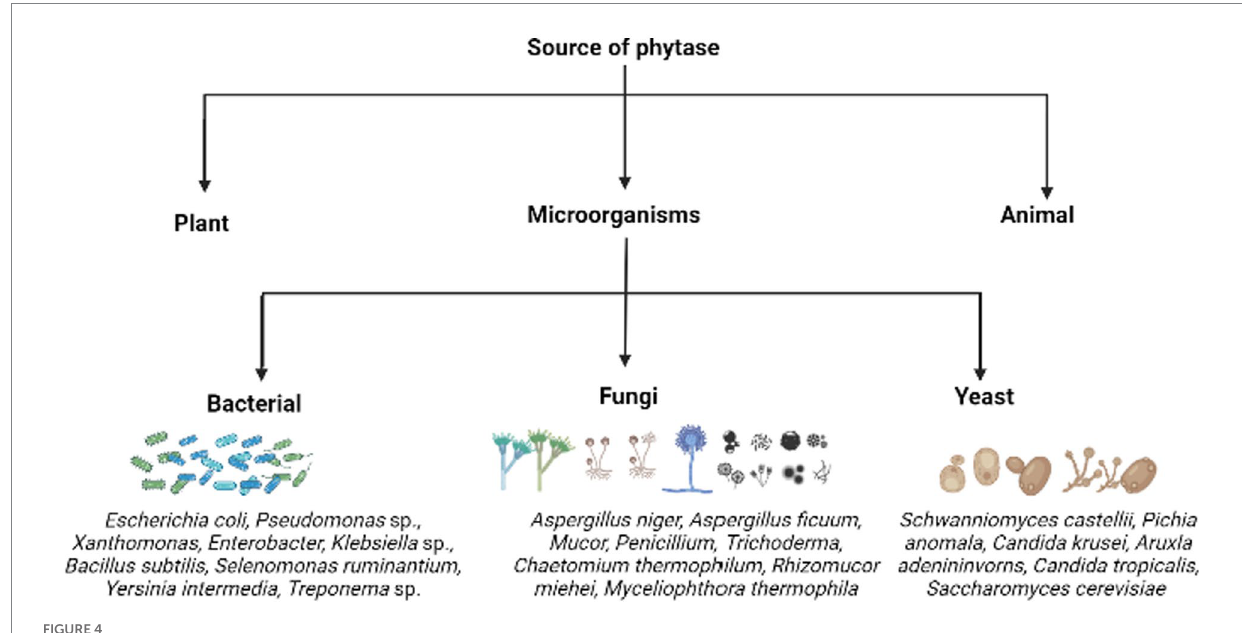
FIGURE 4 The various sources of phytases highlighting certain examples of phytate/phosphate solubilizing